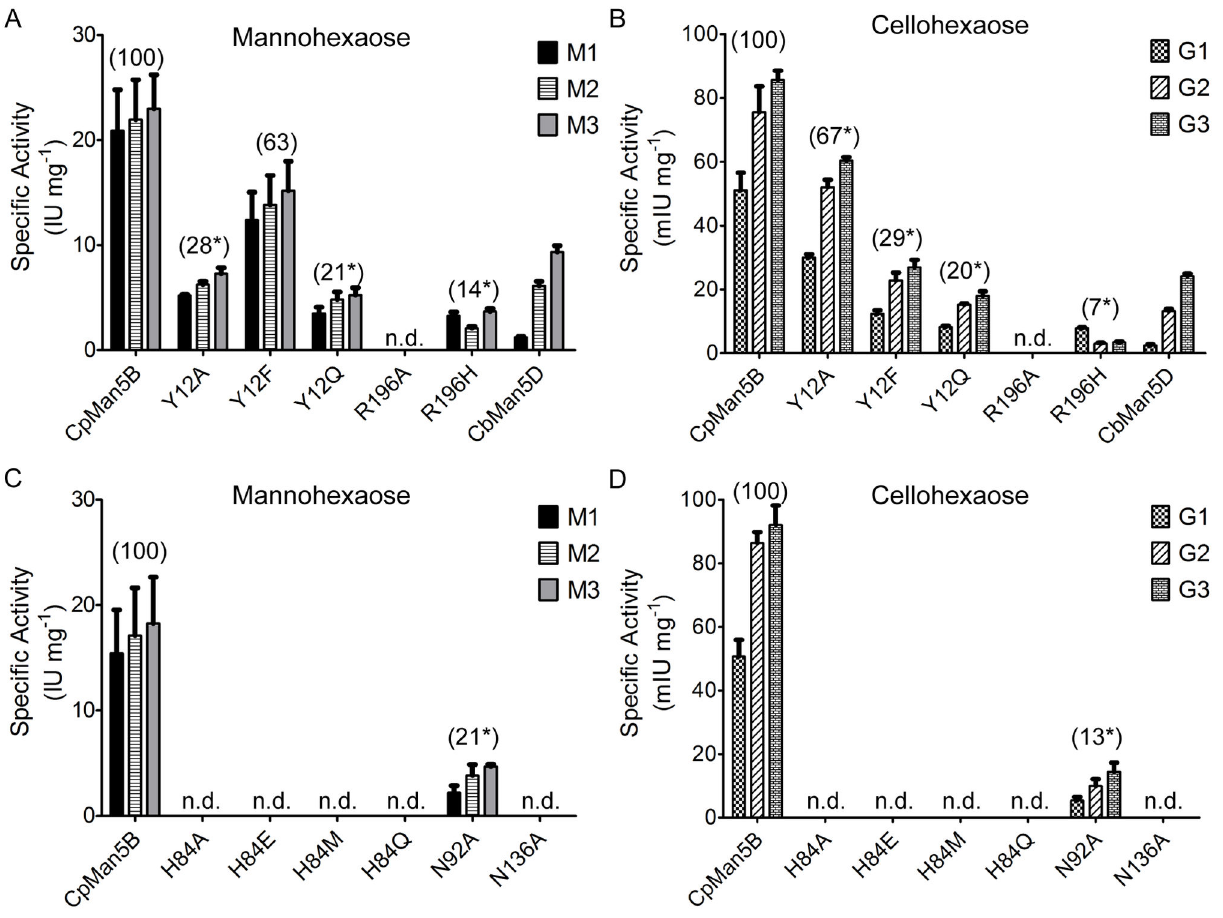
Figure 4. Specific activities of wild-type and mutant CpMan5B enzymes and the CbMan5D enzyme. Rates of product formation from either mannohexaose (Panels A, C) or cellohexaose (Panels B, D) were determined after 10 minutes and 8 hours, respectively, when the rates of product formation by the wild-type enzymes were linear with time. The amino acid changes in the x- axes labels indicate the site-specific mutants of the CpMan5B enzyme. Parenthetical values above the bars show the percentage of wild-type CpMan5B activity, and asterisks indicate that the raw data are significantly different (P<0.05, Student's paired t test) from those of the wild-type CpMan5B enzyme in the same experiment. Abbreviations: M1, mannose; M2, mannobiose; M3, mannotriose; G1, glucose; G2, cellobiose; G3, cellotriose; n.d., end product(s) was not detected under these assay conditions; IU,